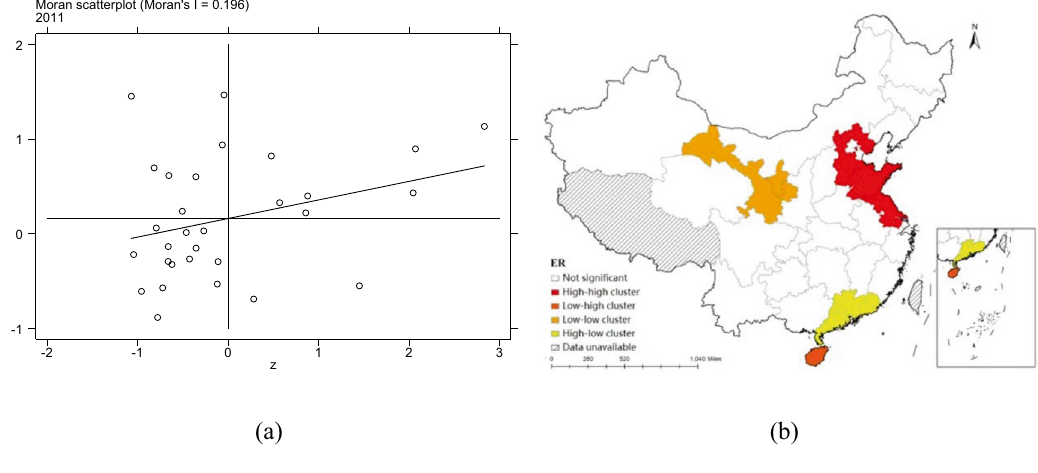
Figure 8. Moran scatter plot and LISA aggregation plot of